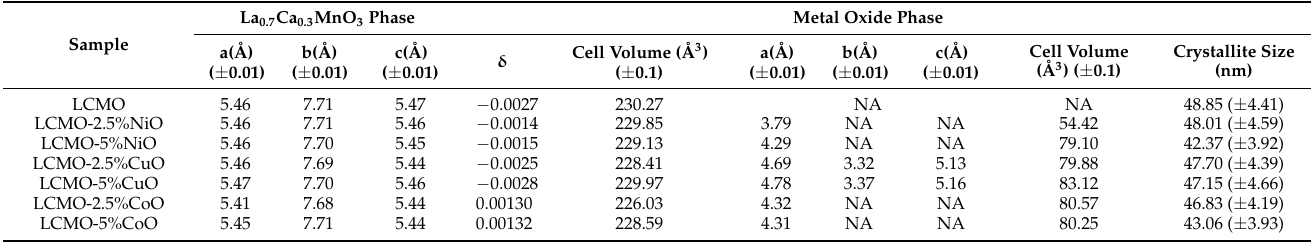
Table 2. Lattice parameters, cell volume, unit cell anisotropy, and crystallite size of LCMO and MO phase in LCMO–MO composite